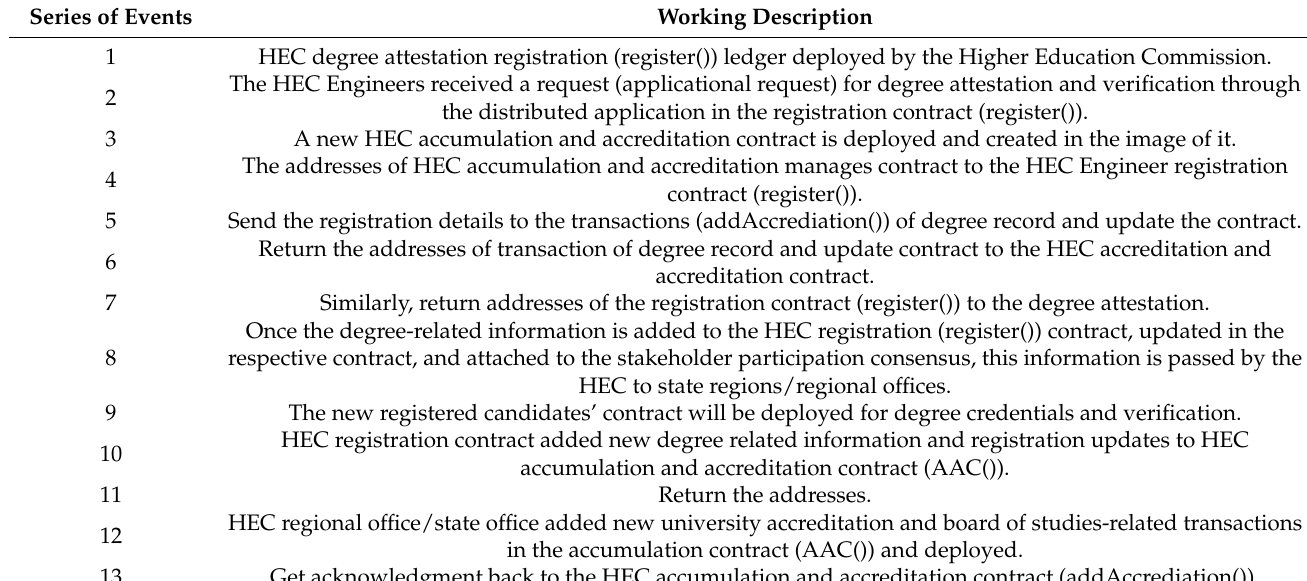
Table 3. List of events of nodes transactions and execution of proposed HEC degree attestation traceability architecture. Series of Events Working